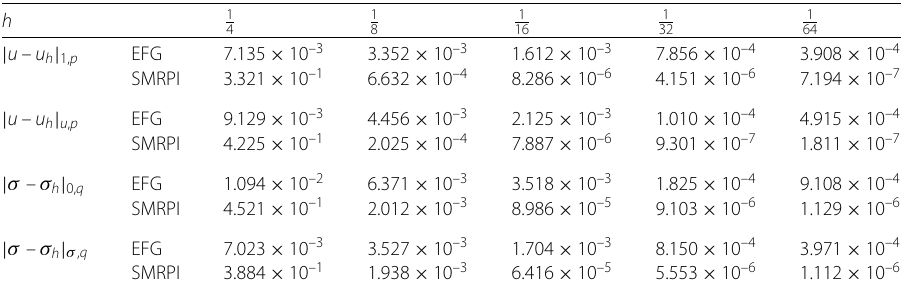
Table 2 Comparing the errors with different types of norms and quasi-norms for Example 2 with p = 1.5 and s = 0.6 for SMRPI and EFG methods h 1